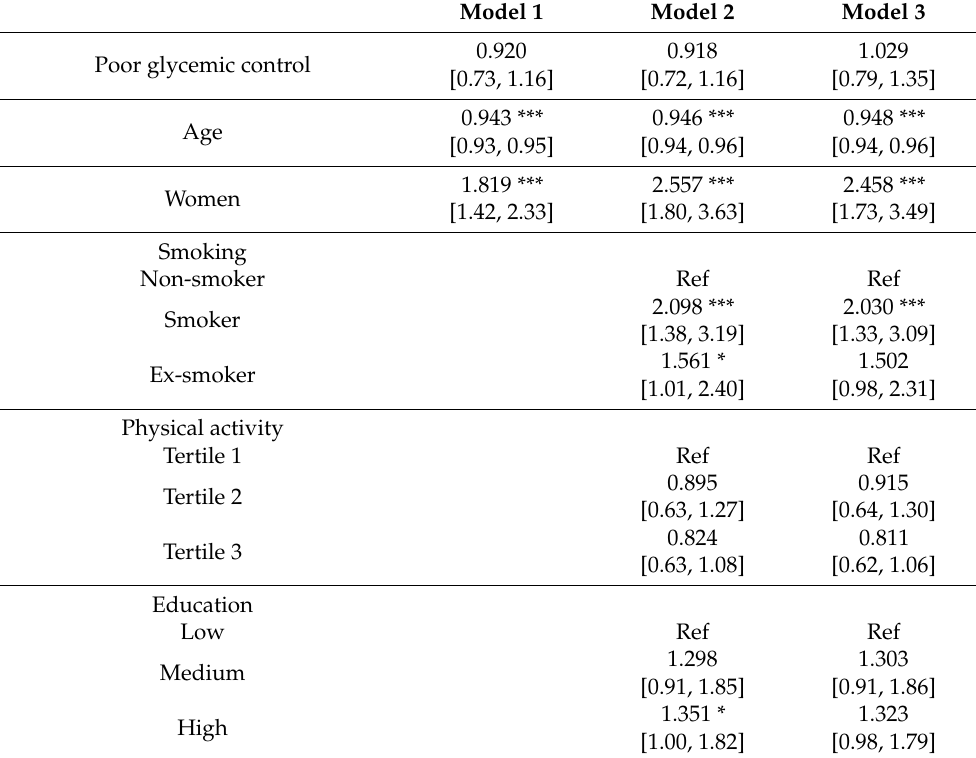
Table 2. logistics regression for factors associated with the presence of depressive symptoms Odds ratio [95%